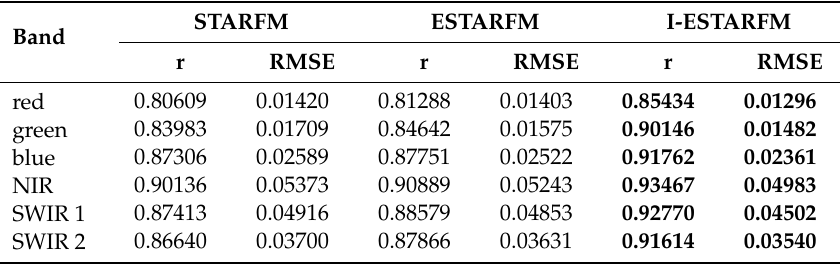
Table 5. Accuracy assessment results of study area 3.